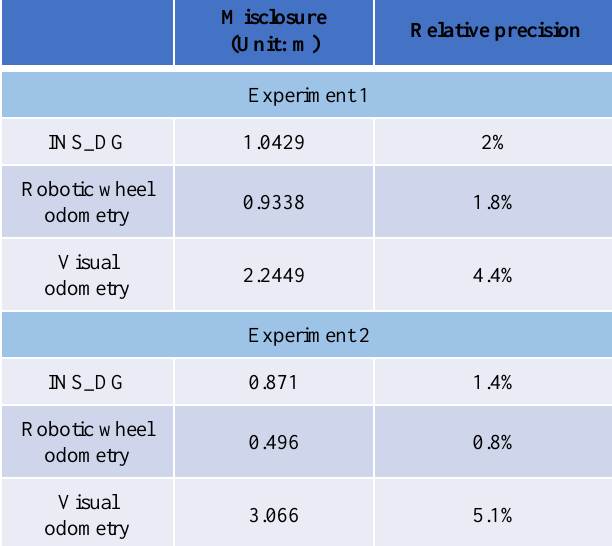
Table 2. The misclosure and relative precision